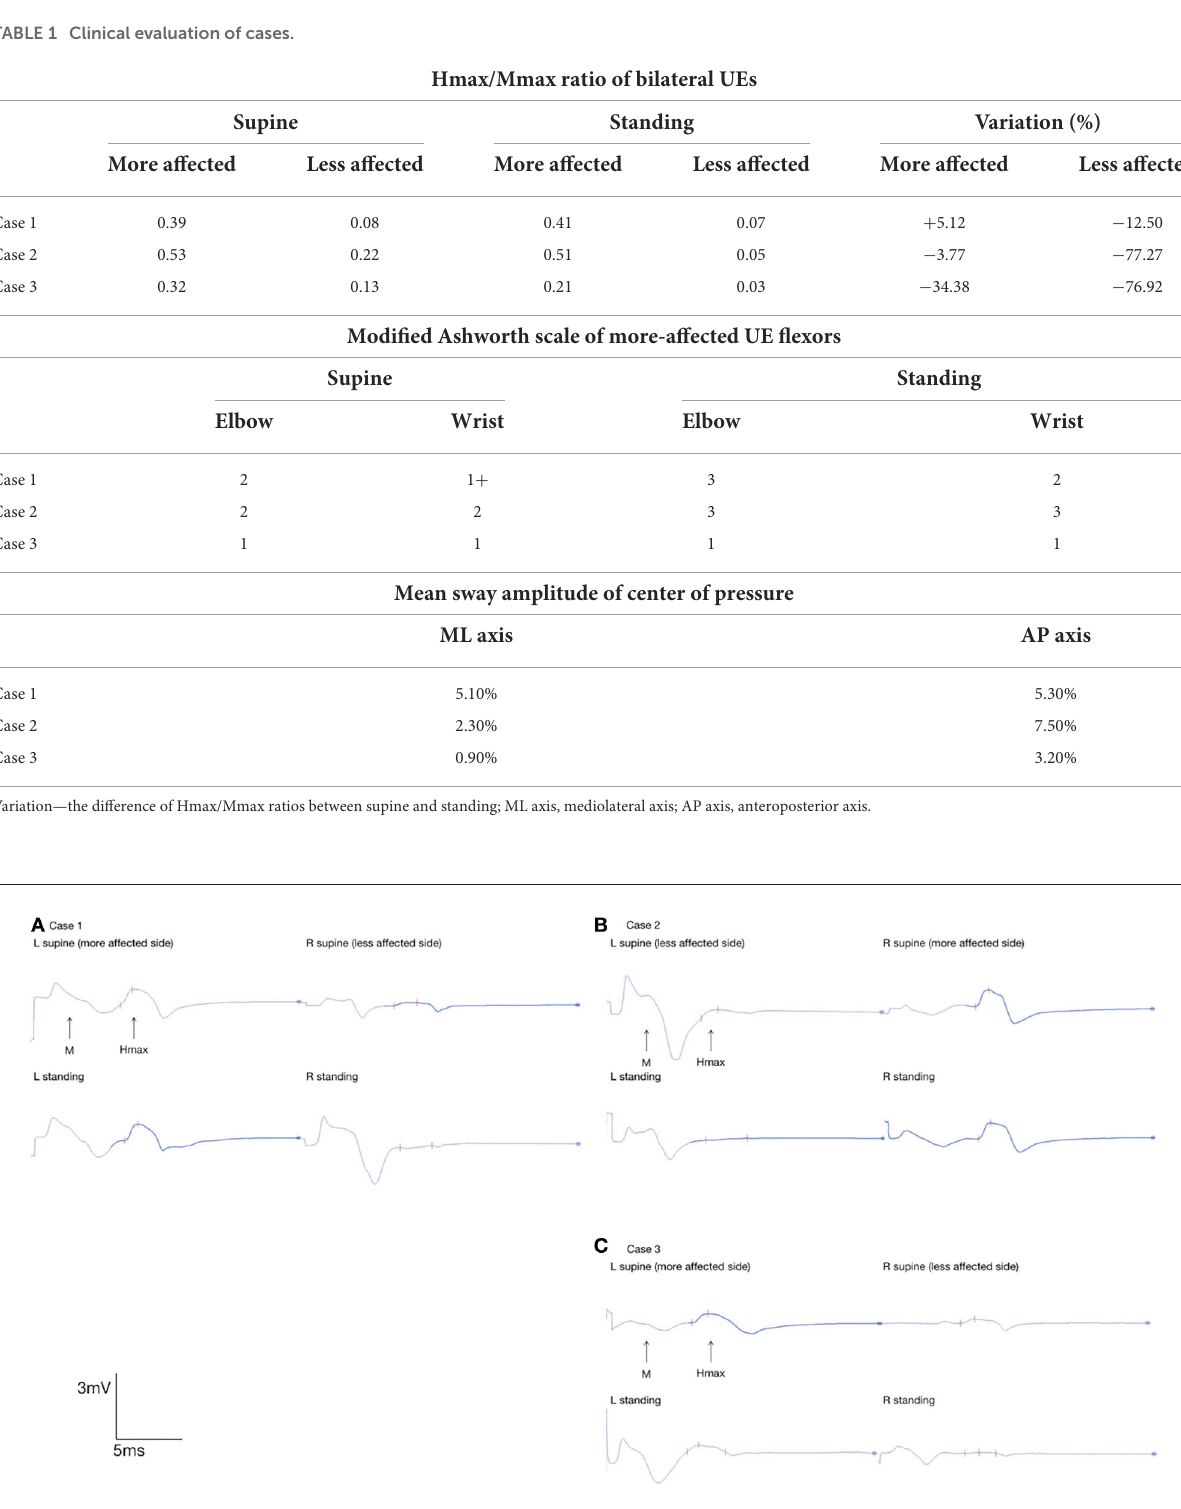
TABLE 1 Clinical evaluation of cases.